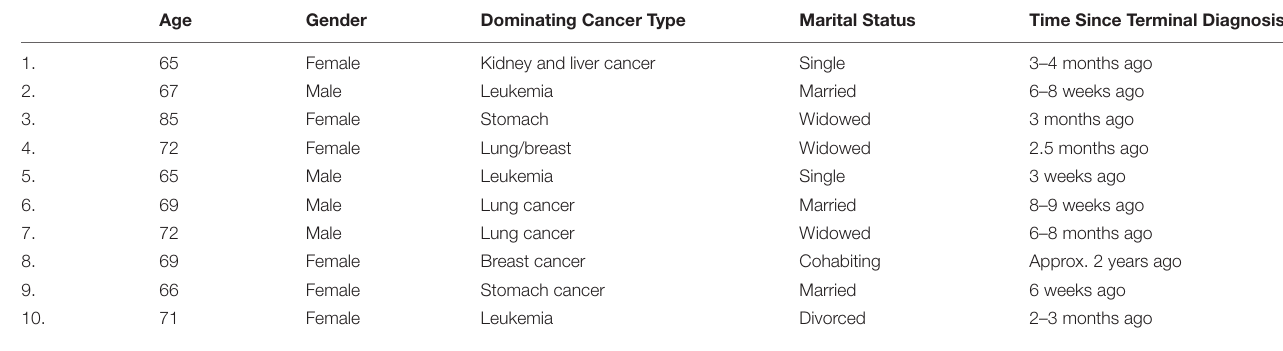
TABLE 2 | Participants